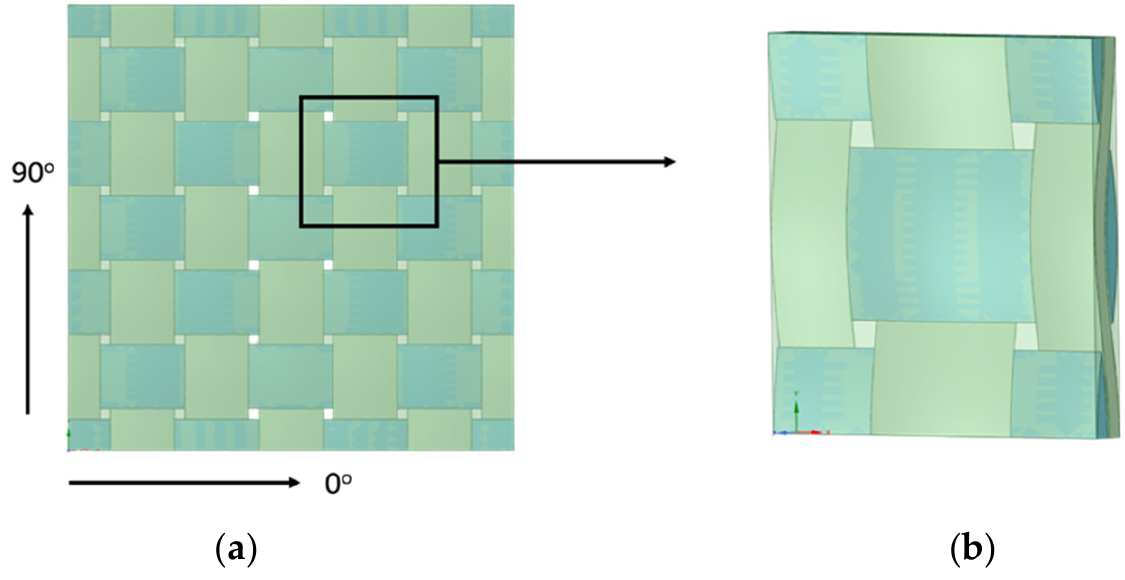
Figure 2. Structure of the carbon fiber fabric with: ( a ) direction 0° and 90°; ( b ) zoom-in view.